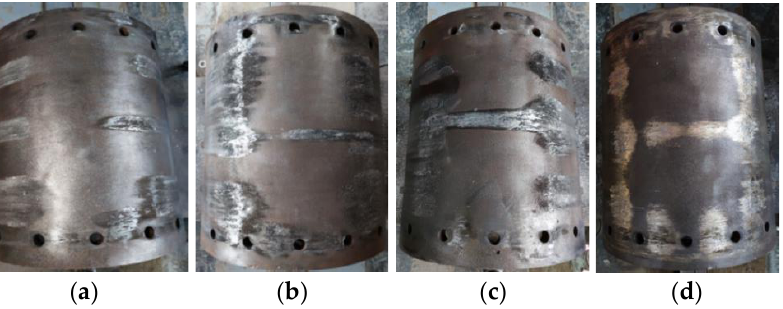
Figure 8. Specimen H350-4-1: ( a ) H350-4-1; ( b ) Brass abrasion; ( c ) Abrasion of lower arc end-plate.